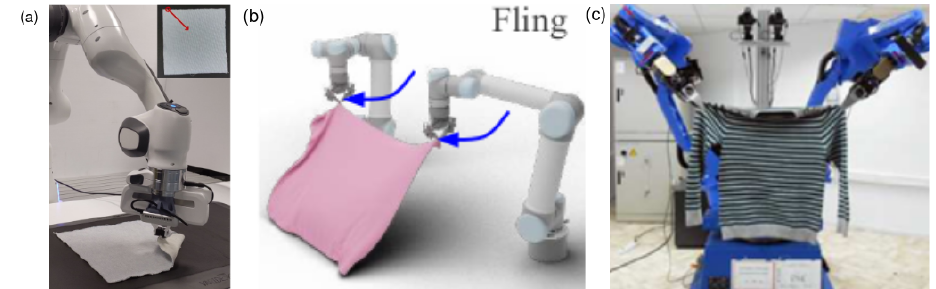
Figure 5. Action primitives in cloth shaping: ( a ) Pick-and-Place by Lee et al. (2021) [229], ( b ) Pick- and-Fling by Ha et al. (2022) [227] and ( c ) Gravity-based cloth flattening by Doumanoglou et al. (2014a) [10]. Figures reproduced with